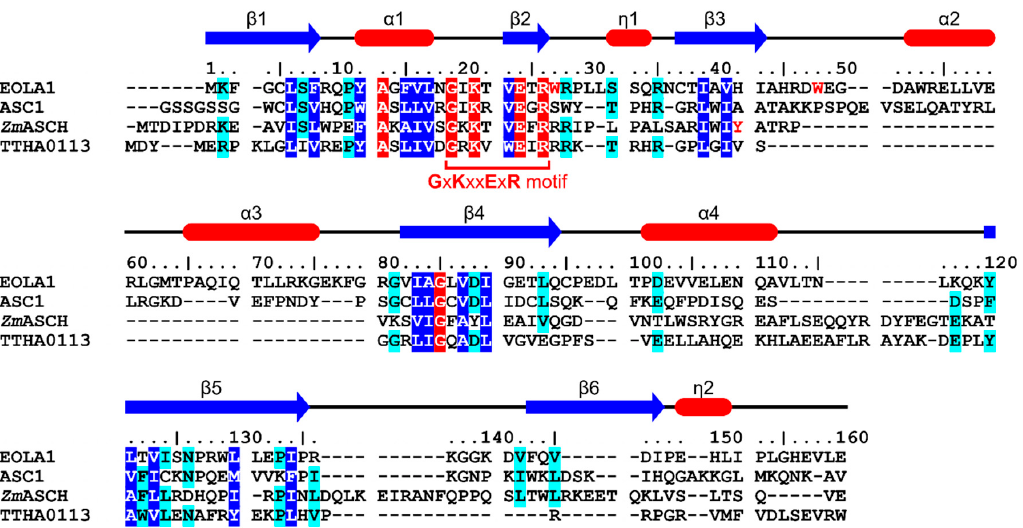
Figure 2. Sequence alignment of EOLA1 with structurally similar proteins. Sequences alignment of EOLA1, ASC-1, Zm ASCH, and TTHA0113 based on Dali analyses [19]. The secondary structure of EOLA1 is shown above its sequence; helices and β -strand are represented as red tubes and blue arrows, respectively. Identical and conserved residues among four proteins are marked with red and blue boxes, respectively. Conserved residues among three of four proteins are marked with cyan boxes.